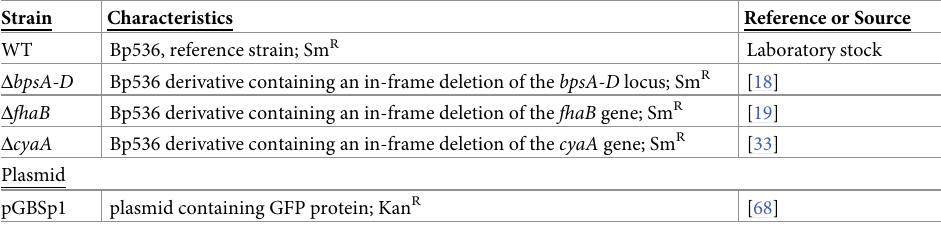
Table 3. Strains and